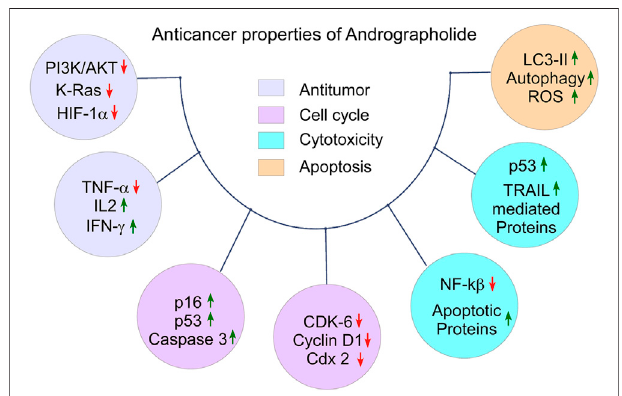
FIGURE 3 | The anticancer properties of Andrographolide: Tumor suppressing property by down-regulating of tumor promoting molecules and up-regulating of anti-tumor molecules, cell cycle arrest by down-regulating of cell cycle promoting factors and up-regulating of cell cycle arresting factors in defected cells, cytotoxicity by promoting autophagy in the abnormal cell, and apoptotic property by down regulating anti-apoptotic proteins and up-regulating pro-apoptotic